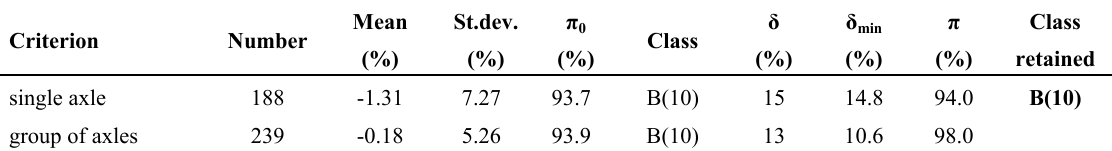
Table 8. Accuracy results of axle weights from influence line method